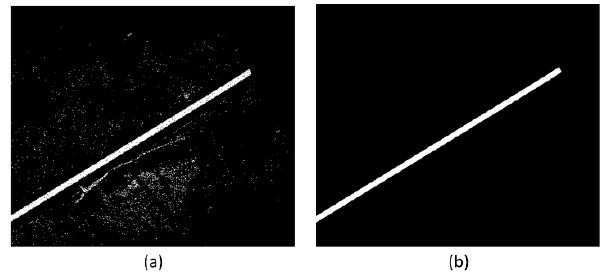
Figure 4. Data pre-processing. (a) Rasterization of pavement and road marking points. (b) Morphological operations are carried out to filter false positives.